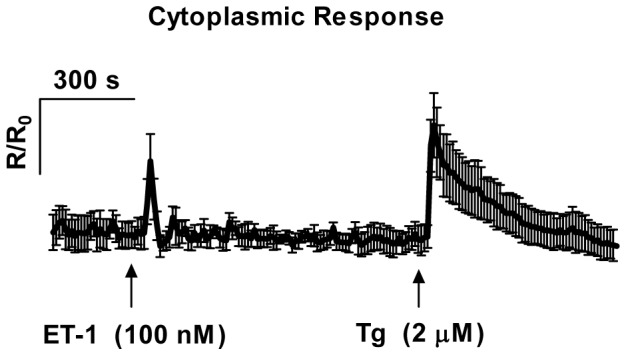
Effects of endothelin-1 and thapsigargin on cytoplasmic Ca2+ signal.Average trace of cytoplasmic Ca2+ signals recorded (10 s intervals) in rat SMCs loaded with Ca2+ indicator Fluo-4 AM. ET-1 (100 nM) initially causes a spike in [Ca2+]i, and subsequent inhibition of SERCA with 2 µM Tg elicits another large [Ca2+]i transient due to depletion of SR luminal Ca2+ (ROI = 15, n = 4 independent experiments, mean ± SEM, P<0.005).